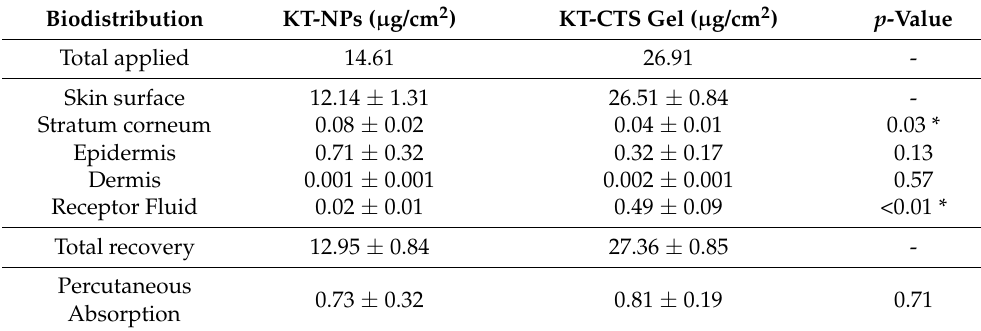
Table 4. Skin distribution of KT (expressed as µ g/cm 2 ) contained in the formulations with an in vitro test after an exposure time of 24 h. Values are expressed as mean ± SD ( n = 6).